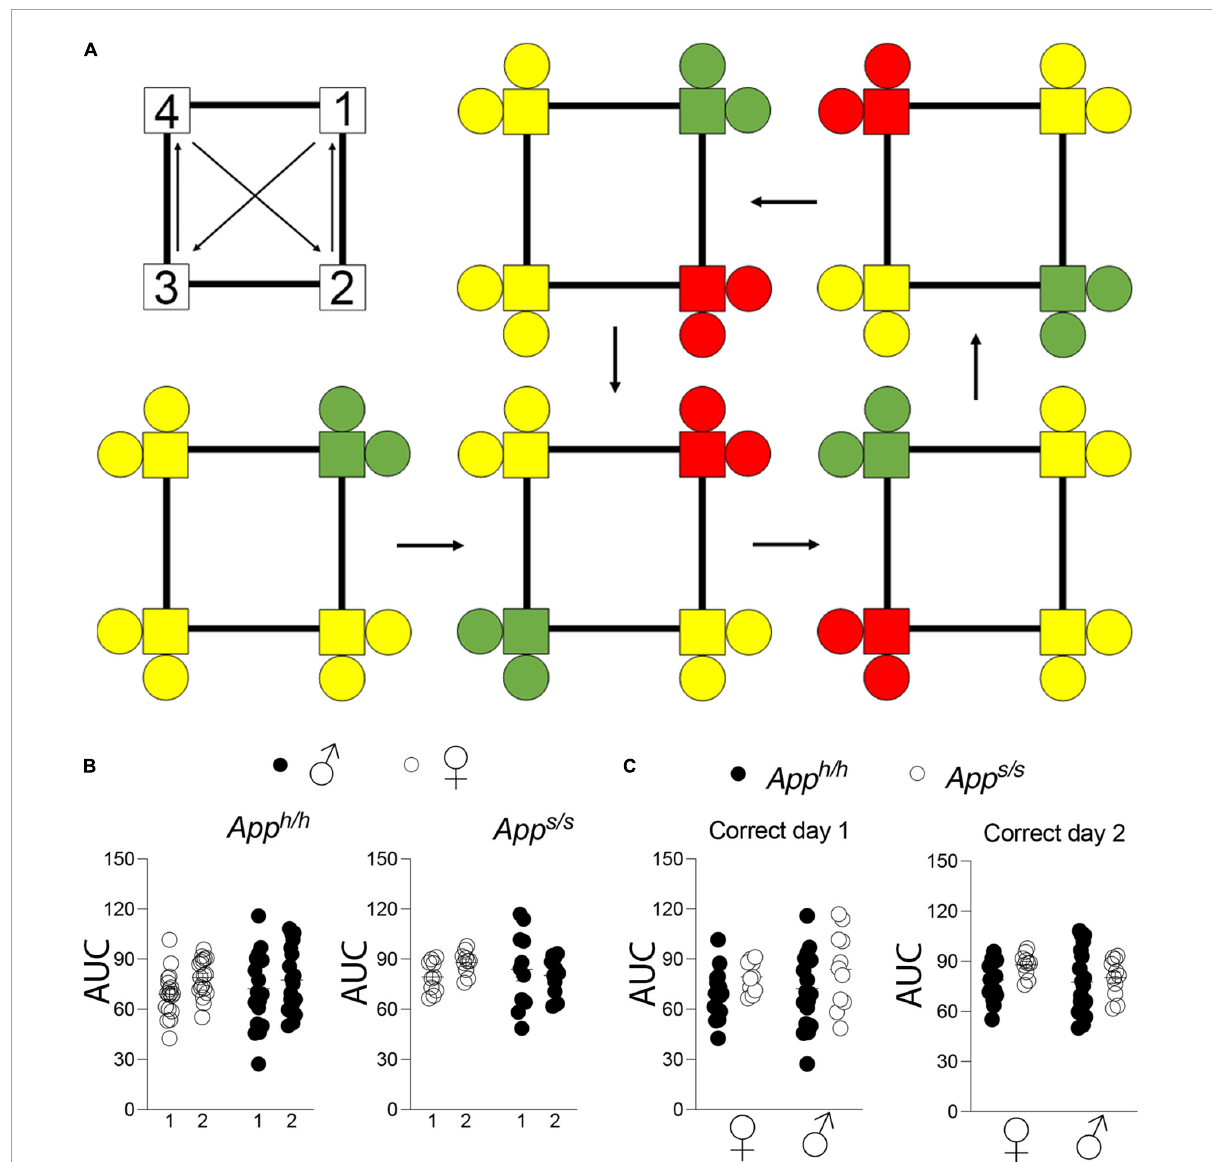
FIGURE2 Place learning with corner switch analysis of App h / h and App s / s rats. (A) Schematic of corner switching program on top left, with a 45 min between each corner switch. For rats assigned to corner 1, bottom left, green indicates “correct” corner which then alternates to an adjacent corner every 45 min (arrows), with yellow indicating “incorrect” corners and red indicating “incorrect, previously correct” corner. (B) Area under the “correct” learning curve analysis for individual rats stratified by each day of the drinking session. Data are represented as mean ± SEM and were analyzed by two–way RM ANOVA followed by post-hoc Sidak’s multiple comparisons test when ANOVA showed significant differences ( App h / h rats: day factor, F ( 1 , 35 ) = 3.540, P = 0.0683; sex factor, F ( 1 , 35 ) = 0.05113, P = 0.8224; day × sex interaction, F ( 1 , 35 ) = 1.041, P = 0.4525. App s / s rats: day factor F ( 1 , 19 ) = 0.3123, P = 0.5828; sex factor, F ( 1 , 19 ) = 0.1210, P = 0.5059; day × sex interaction, F ( 1 , 19 ) = 1.900, P = 0.1840). (C) Area under the “correct” learning curve analysis for individual rats stratified by sex and genotype. Data are represented as mean ± SEM and were analyzed by two–way ANOVA followed by post-hoc Sidak’s multiple comparisons test when ANOVA showed significant differences. Correct day 1: sex factor F ( 1 , 54 ) = 0.6217, P = 0.4339; genotype factor, F ( 1 , 54 ) = 2.078, P = 0.0812; sex × genotype interaction, F ( 1 , 54 ) = 0.01476, P = 0.9037. Correct day 2: sex factor, F ( 1 , 54 ) = 1.406, P = 0.2409; genotype factor, F ( 1 , 54 ) = 2.330, P = 0.1328; sex × genotype interaction, F ( 1 , 54 ) = 0.6338, P = 0.4294. We tested 18 female App h / h , 19 male App h / h , 10 female App s / s , and 11 male App s / s . No animals met the exclusion criteria of < 25 visits per drinking session, and none died during the behavioral